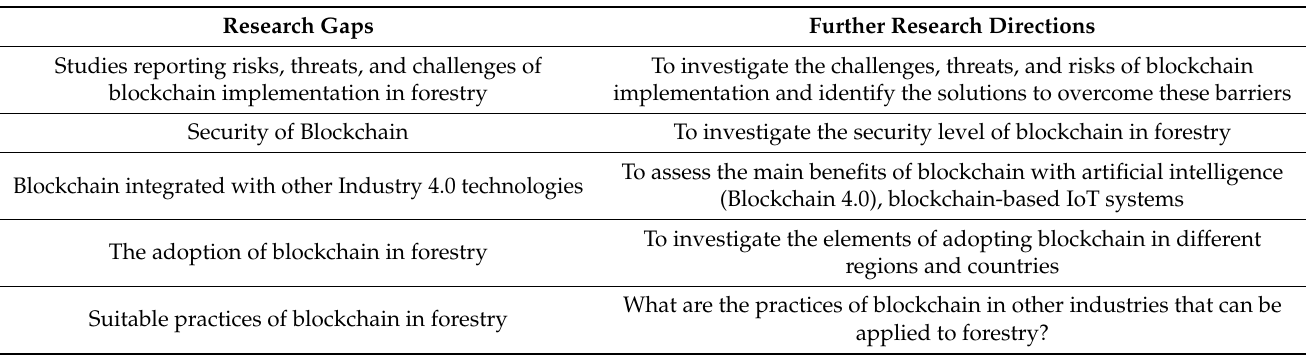
Table 6. Research agenda for future